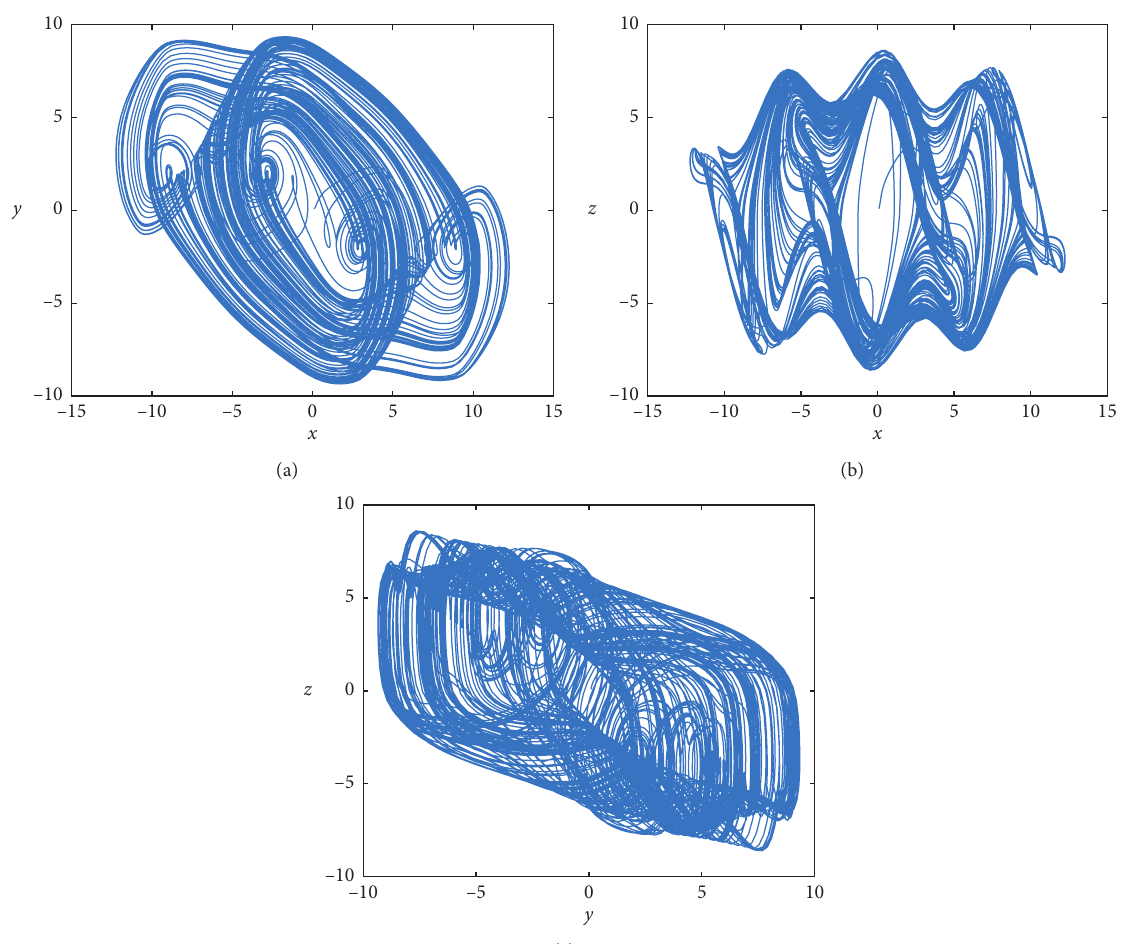
Figure 2: The chaotic attractor of system (4). (a) x - y plane, (b) y - z plane, and (c) x - z plane.